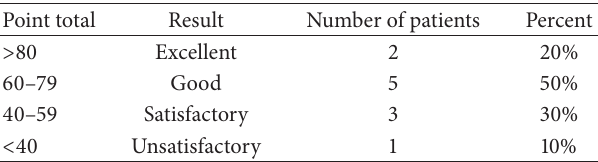
Table 3: The analysis of the Ankle Scores (AS) from the group of patients using the modified method based on Pirogow.